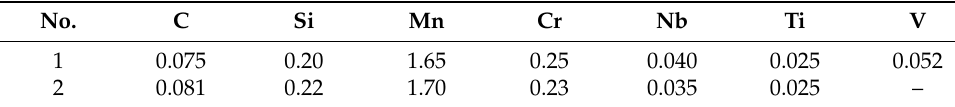
Table 1. Chemical composition of the testing steel